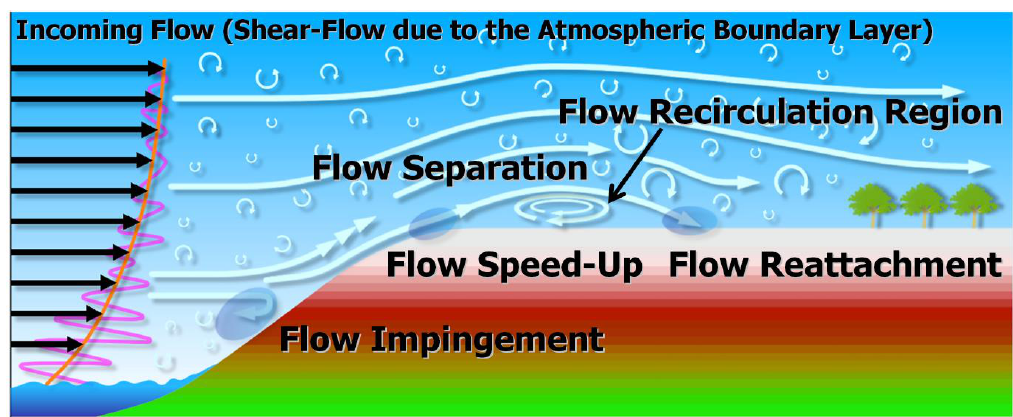
ff ect of topography on wind behavior in complex Figure 1. Effect of topography on wind behavior in complex terrain. Figure 1. E